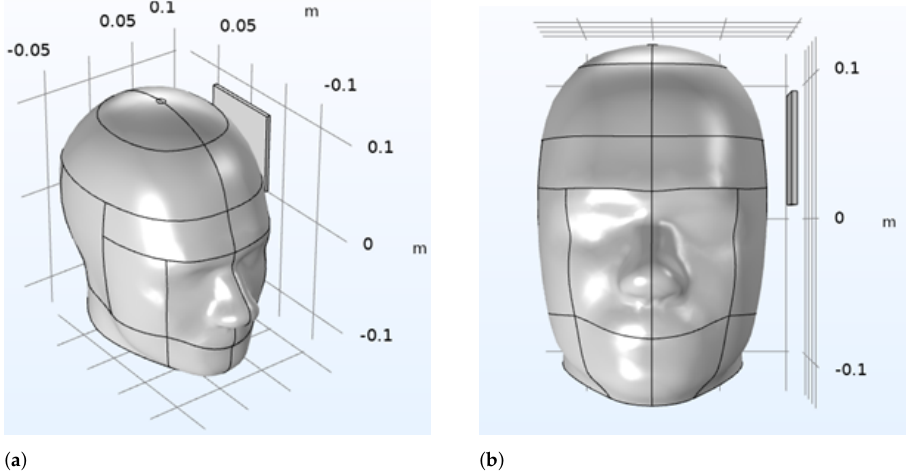
Figure 1. ( a ) and ( b ) Human head model and mobile device.